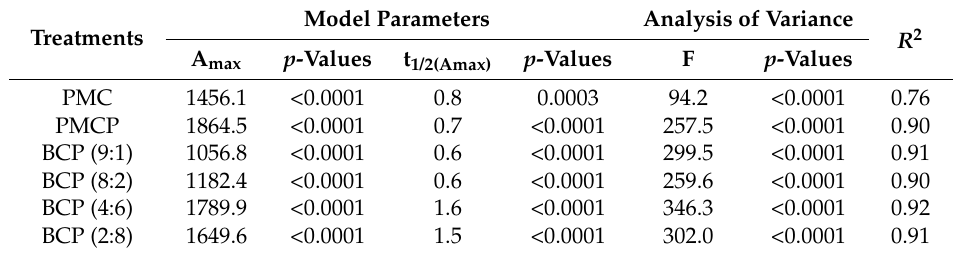
Table 4. Estimation model for accumulated K releasing amount from different types of biochar